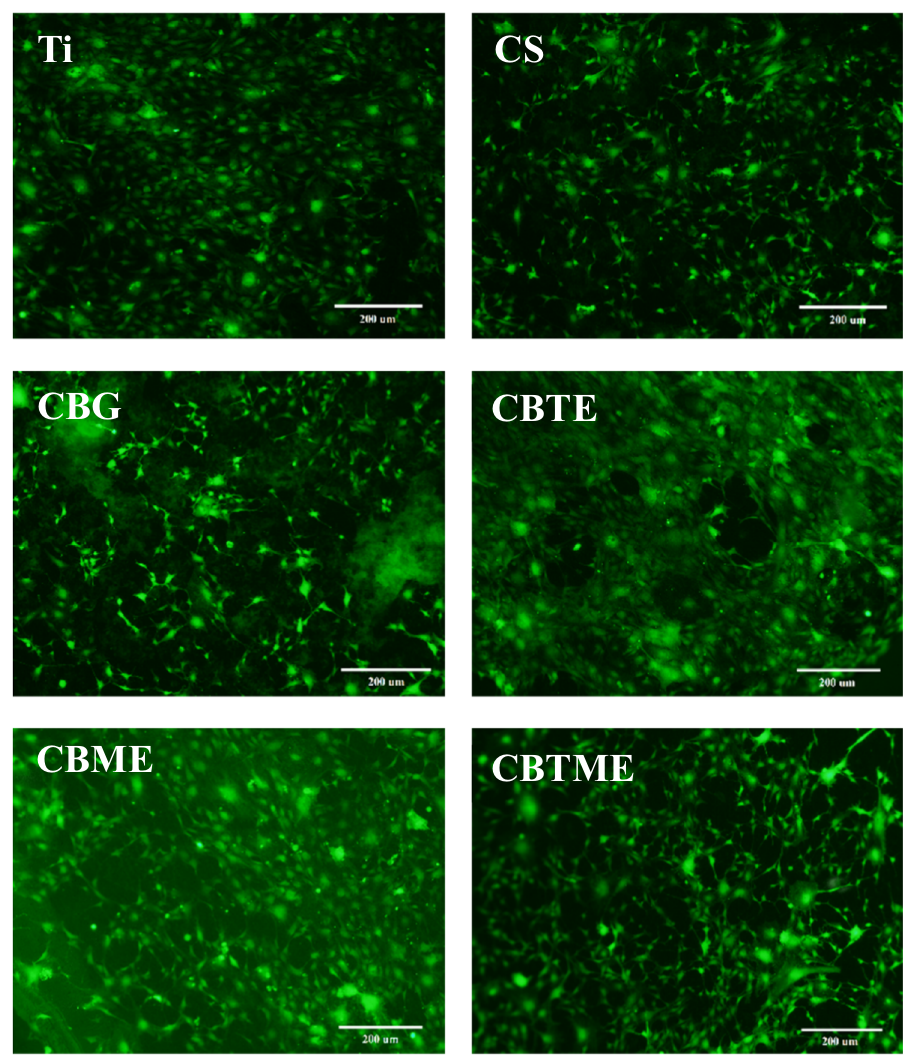
Fig. 5 Fluorescence images after live/dead staining of MC3T3 cells cultured for 2 days on experimental groups